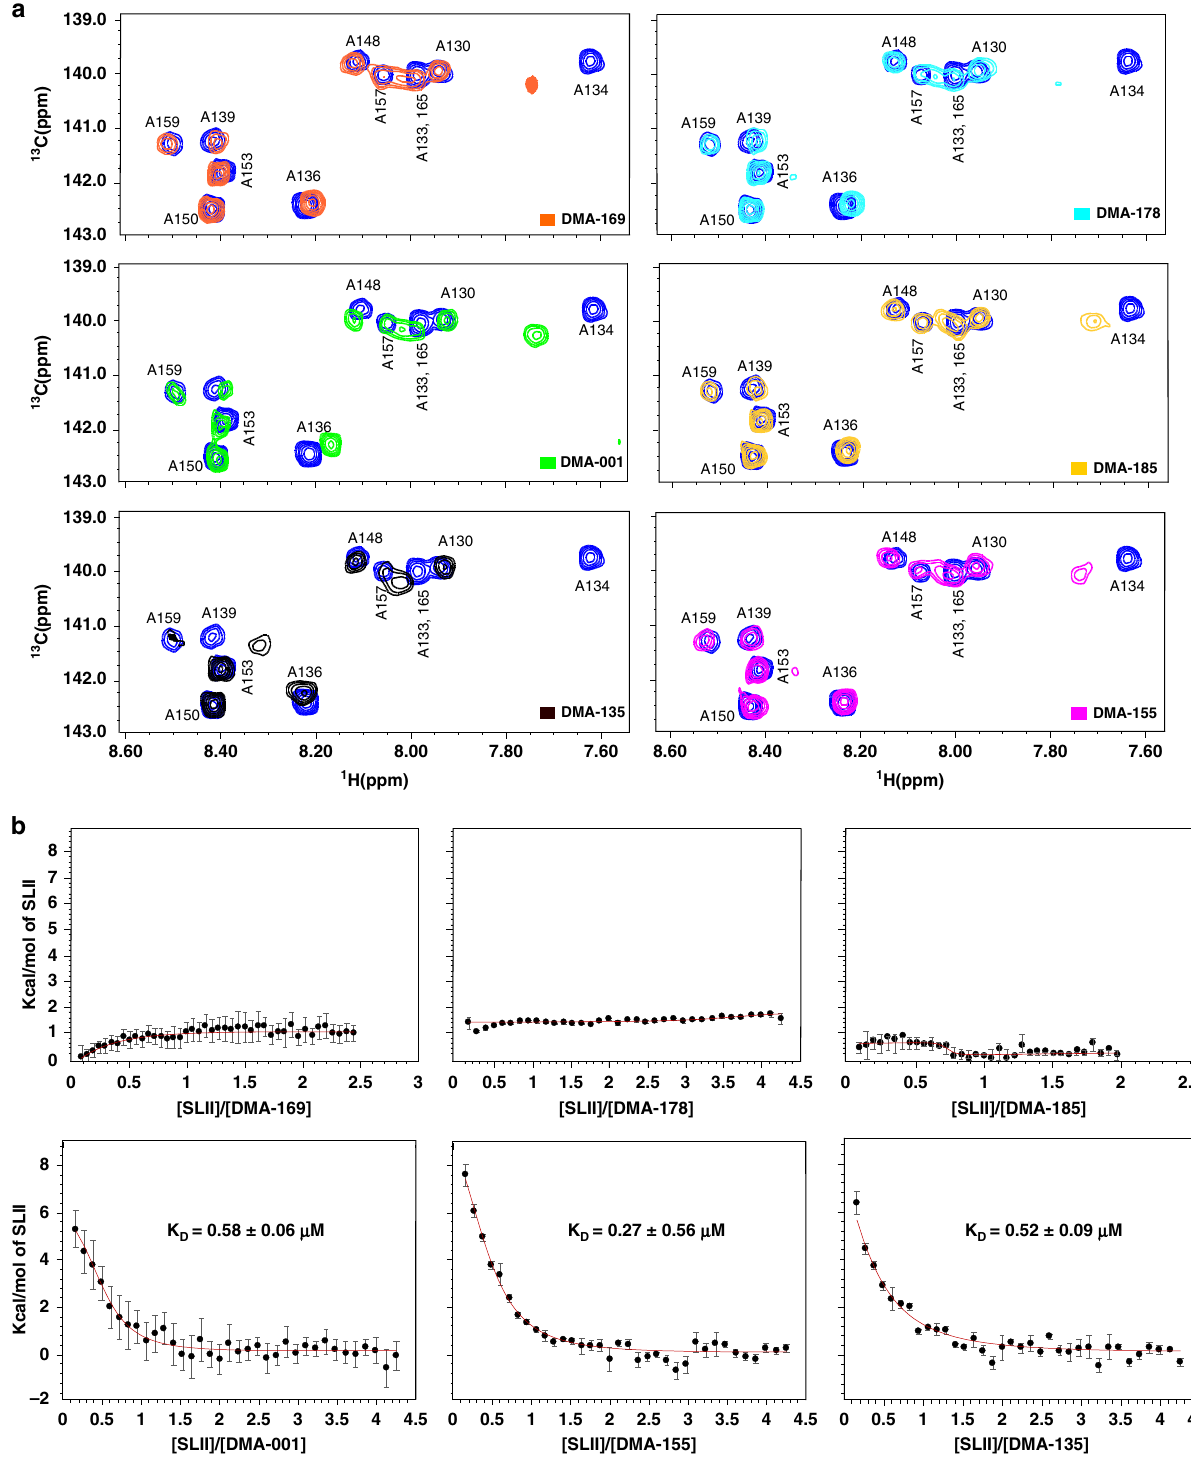
evaluated whether the SMs affected EV71 IRES-dependent translation in cells using a dual-luciferase assay. The description of the bicistronic reporter plasmid, pRHF-EV71-5 ′ UTR, used here has been described elsewhere 13 . In brief, the pRHF-EV71-5 ′ UTR plasmid was used as a template to in vitro transcribe the dual-luciferase reporter RNA (Fig. 3a), which was subsequently transfected into SF268 cells. Each SM was added to the cells at